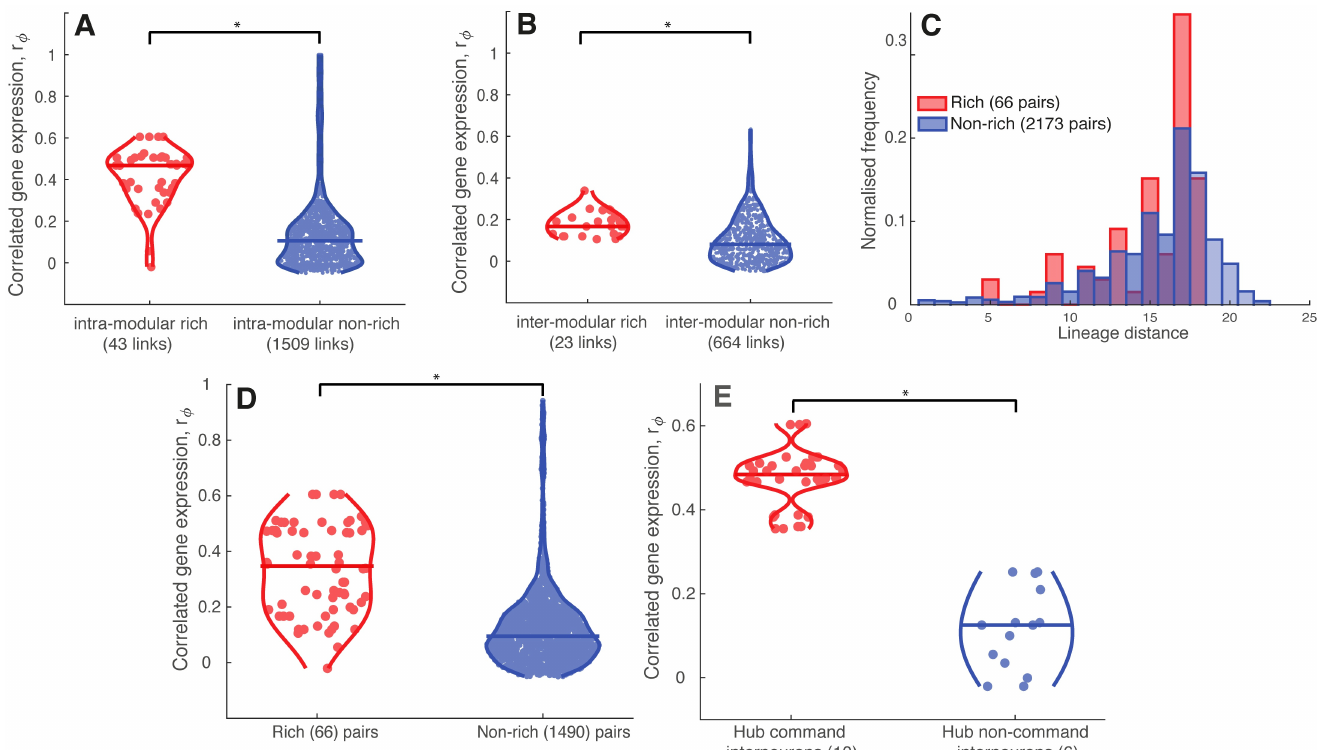
Fig 8. Increased CGE of hub neurons is not driven by modularity, neuronal birth time, or cell lineage distance. (A) Distributions of CGE, r rich (red) non-rich (blue) connections, shown as violin plots with the median shown as a horizontal bar (Wilcoxon rank sum test, p = 6.9 × 10 −17 ). (B) Distributions of CGE, r ϕ , for inter-modular rich (red) and non-rich (blue) connections, shown as violin plots with the median shown as a horizontal bar (Wilcoxon rank sum test, p = 1.6 × 10 −5 ). (C) Distributions of lineage distance between rich links (red) and non-rich links (blue), plotted as histograms due to a discrete nature of this measure (Wilcoxon rank sum test, p = 0.079). (D) Distributions of CGE, r ϕ , between early born hubs (rich links, red) and nonhubs (non-rich links, blue) shown as violin plots with the median shown as a horizontal bar (Wilcoxon rank sum test, p = 3.9 × 10 −22 ). (E) Distributions of CGE between hub command interneurons (red) and hub non-command interneurons (blue) shown as violin plots with the median shown as a horizontal bar (Wilcoxon rank sum test, p = 3.3 × 10 −8 ). (cid:3) represents statistically significant